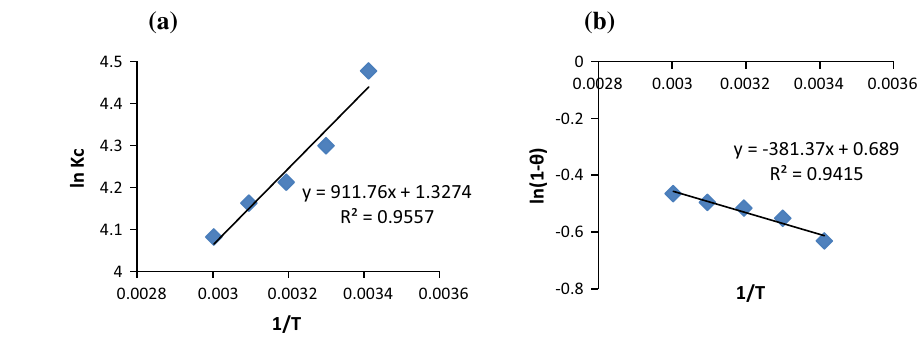
Fig. 5 Van’t Hoff plots for Ni(II) ( a ) and modified Arrhe- nius plots for Ni(II) ( b )